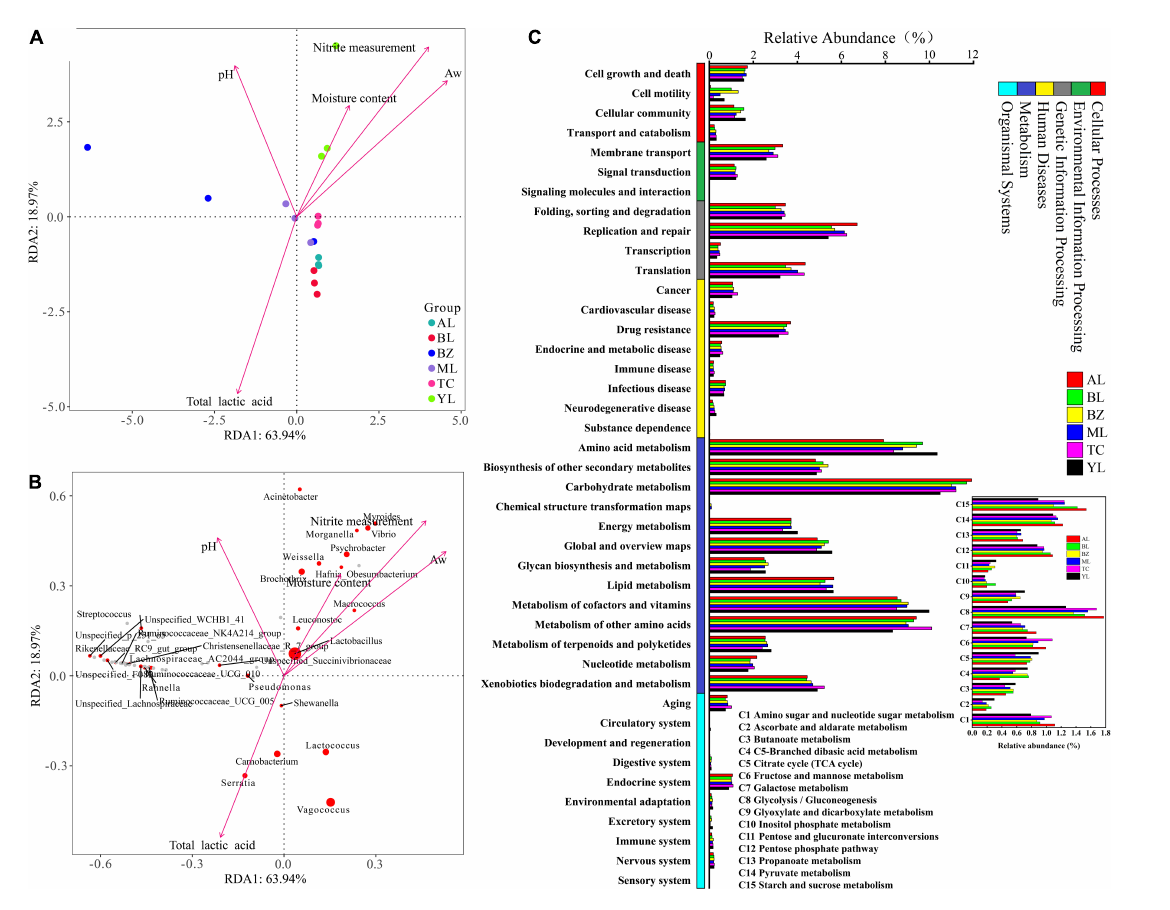
FIGURE3 Redundancy analysis (RDA) of physical factors and samples based on the bacterial community (A,B) and the abundance of KEGG pathways (C) in different smoked horsemeat sausages. In RDA, an acute angle indicates a positive correlation while an obtuse angle indicates a negative correlation between the species and environmental factors. (B) A red circle represents a significant bacterial genus, while the circle space represents the abundance of the species. (C) Bacterial functions at levels 1 and 2 and carbohydrate metabolism at level 3 are